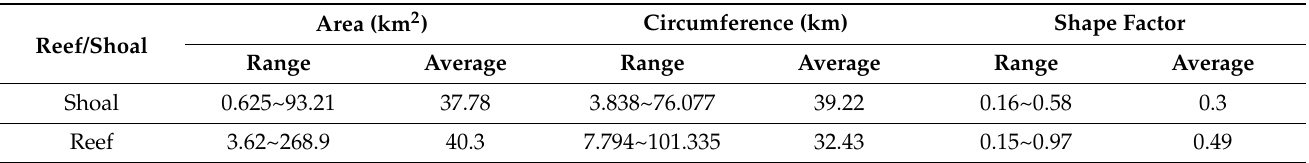
Table 2. Statistical table reef and shoal